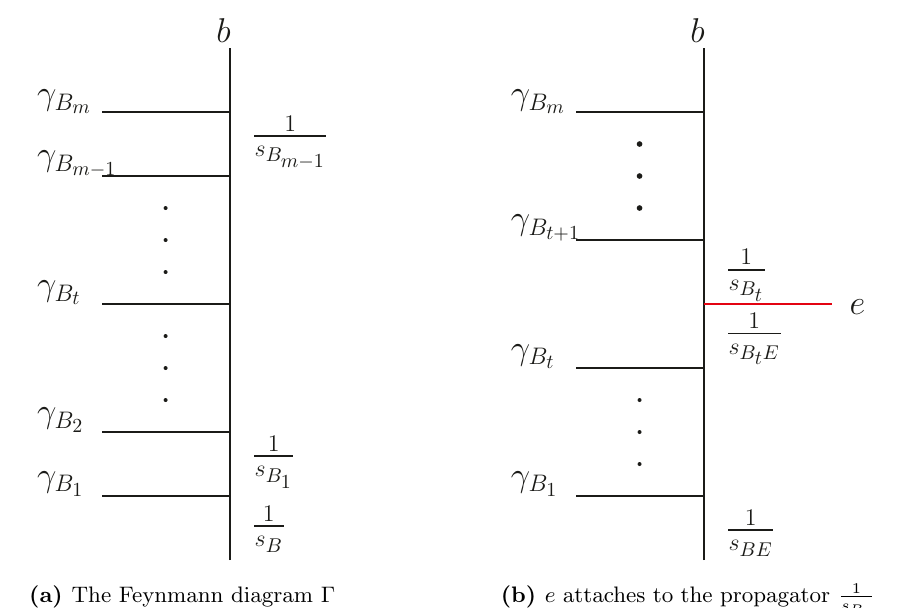
B m (cid:0) 1 B 1 B and the node (cid:26) (cid:26) (cid:1) (cid:1) (cid:1) (cid:26) (cid:26)